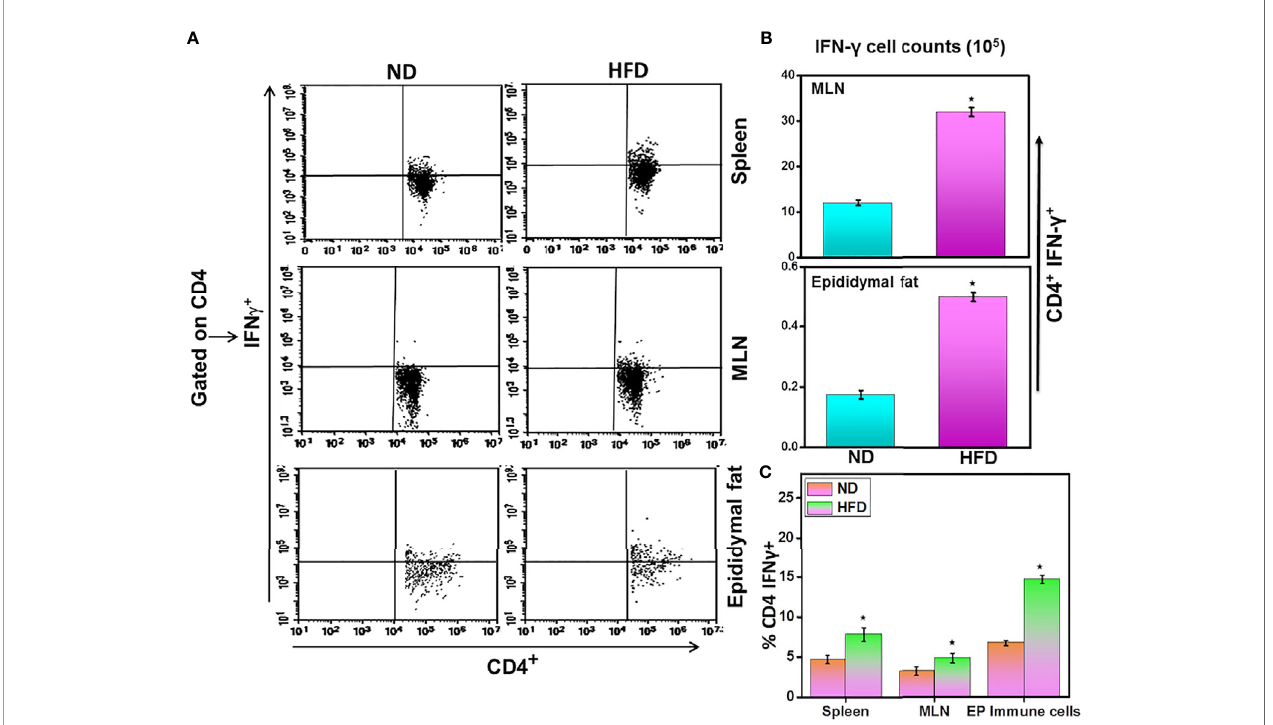
FIGURE 5 | DIO induces Th1 response in adipose tissue. Changes in the absolute numbers and frequency of CD4 + IFN g + T cells in mice 16 weeks after beginning the high-fat diet. Splenic, mesenteric lymph nodes (MLNs), and epididymal adipose cells were isolated from the two groups of mice. The cumulative data showed changes in the frequency and numbers of CD4 + IFN g + cells (A, B) , and the percentage of CD4 + IFN g + (C) were shown as the mean percentage of cells/mouse ± SEM. Three independent experiments; a total of n = 18 involving six mice per group yielded similar results. *p < 0.05, student ’ s t-test indicates statistically signi fi cant differences in numbers and frequency of CD4 + IFN g + in the spleen, MLNs, and epididymal fat between ND and HFD